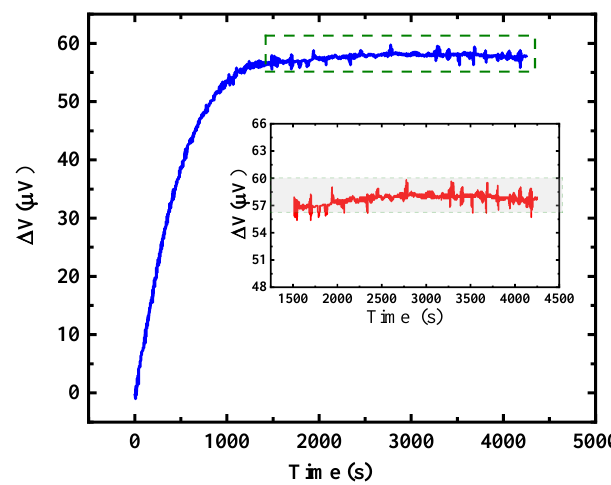
Figure 7. The output voltage fluctuation of a microcantilever in PBS buffer (PH 7.4, 0.01 m) at temperature (20 °C) and 3 V bias voltage. Inset shows the voltage fluctuation is less than 3 μV.